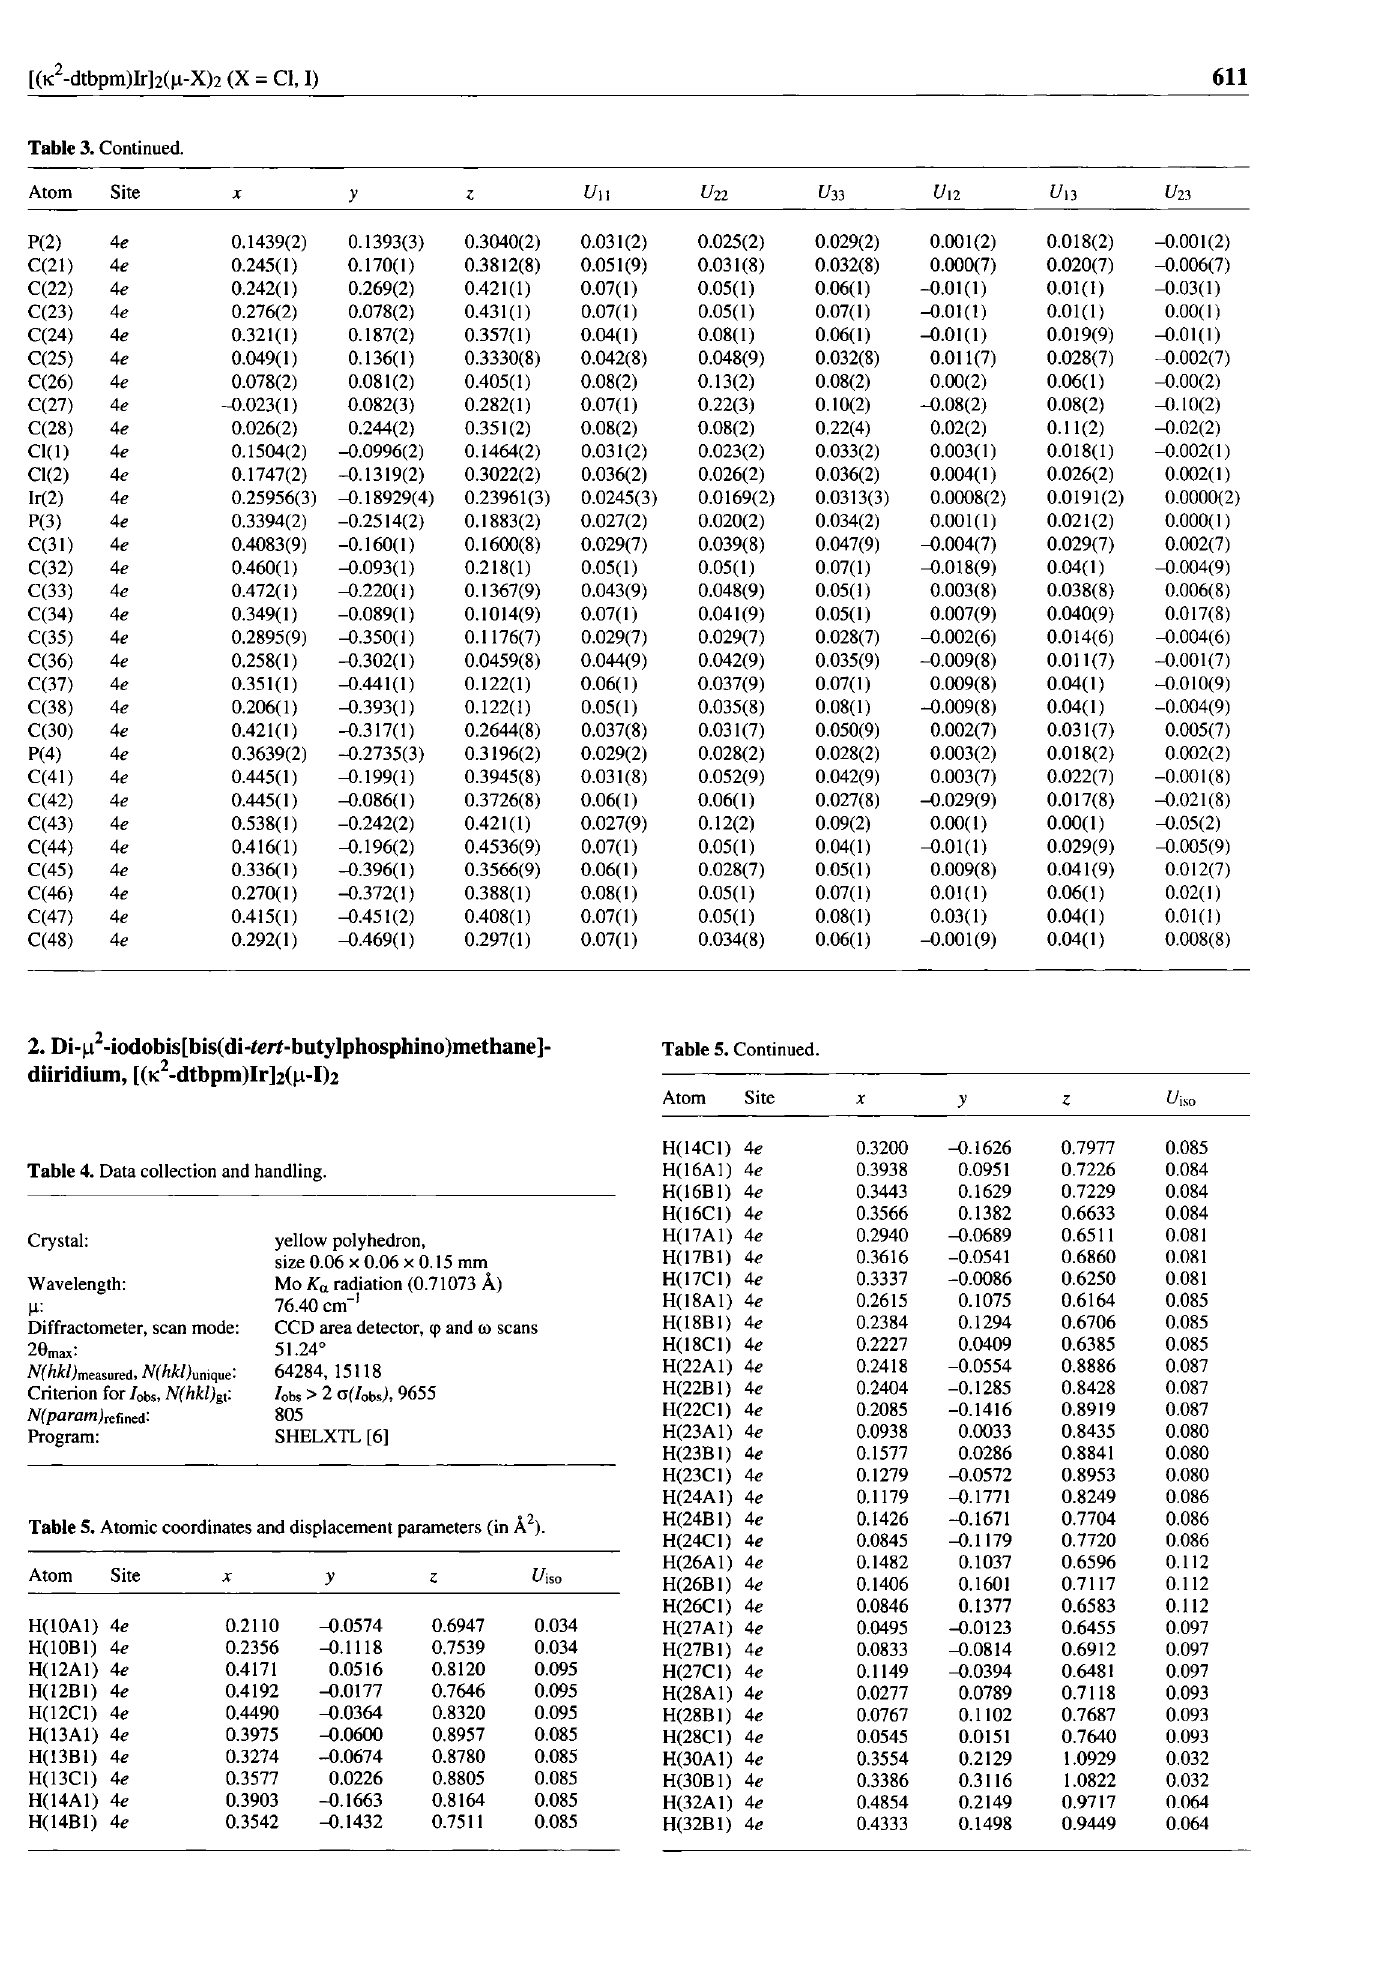
Table S. Atomic coordinates and displacement parameters (in Â 2